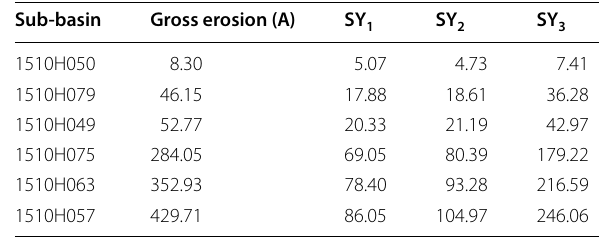
Table 4 Sediment delivery ratio for each sub‑basin Sub-basin